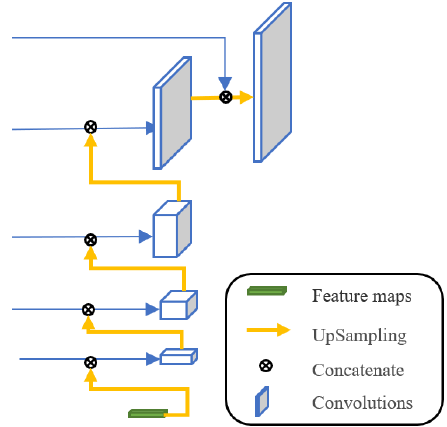
Figure 6. Structure of the feature fusion module.